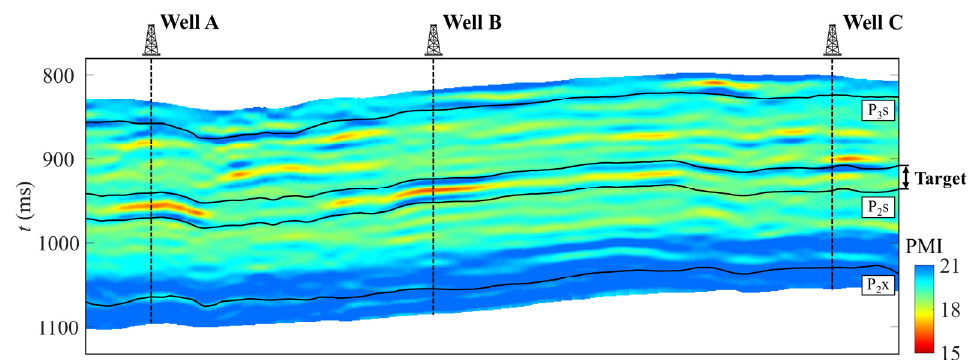
Figure 15. Seismic section of PMI across wells A, B, and C.